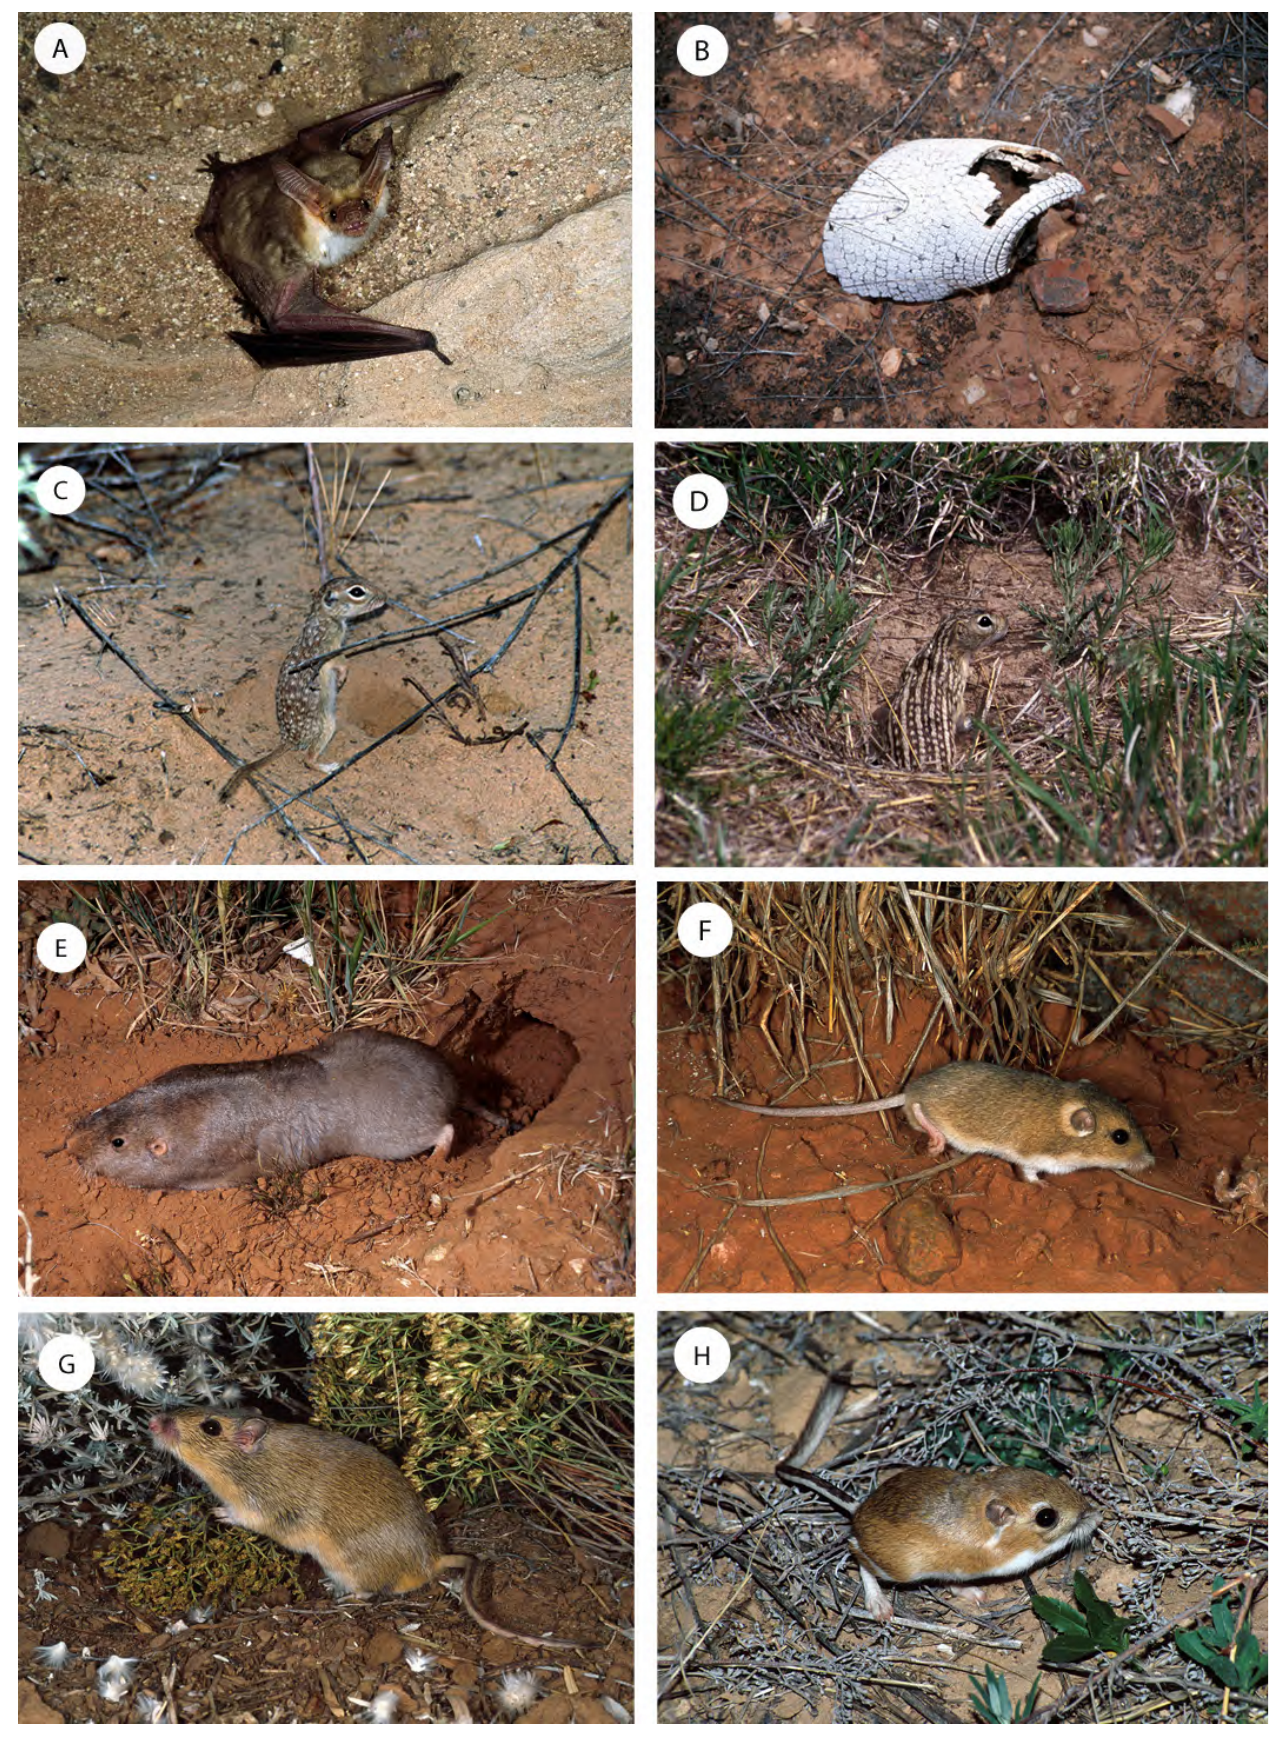
Figure 3. Mammals found in Lake Meredith National Recreation Area, Texas: A : Antrozous pallidus , B : Dasypus novemcinctus (withered shell), C : Xerosper- mophilus spilosoma , D : Ictidomys tridecemlineatus , E : Geomys bursarius , F : Perognathus flavus , G : Chaetodipus hispidus , H : Dipodomys ordii . Photographs by Michael